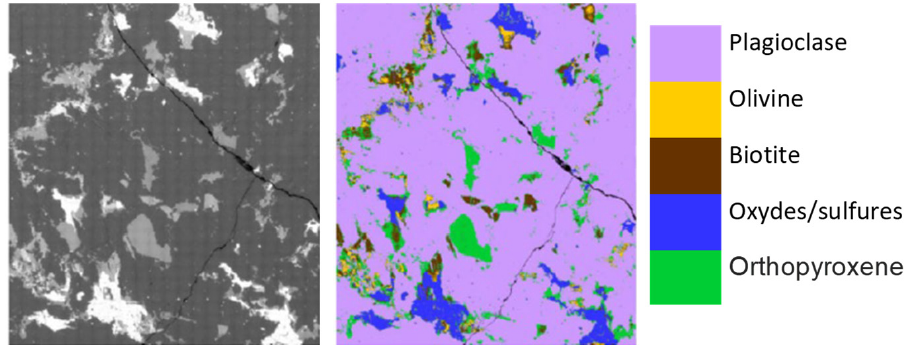
Figure A1. White granite: scattered electrons image (OIS Service Géoscientifiques Inc., Chicoutimi, QC, Canada).